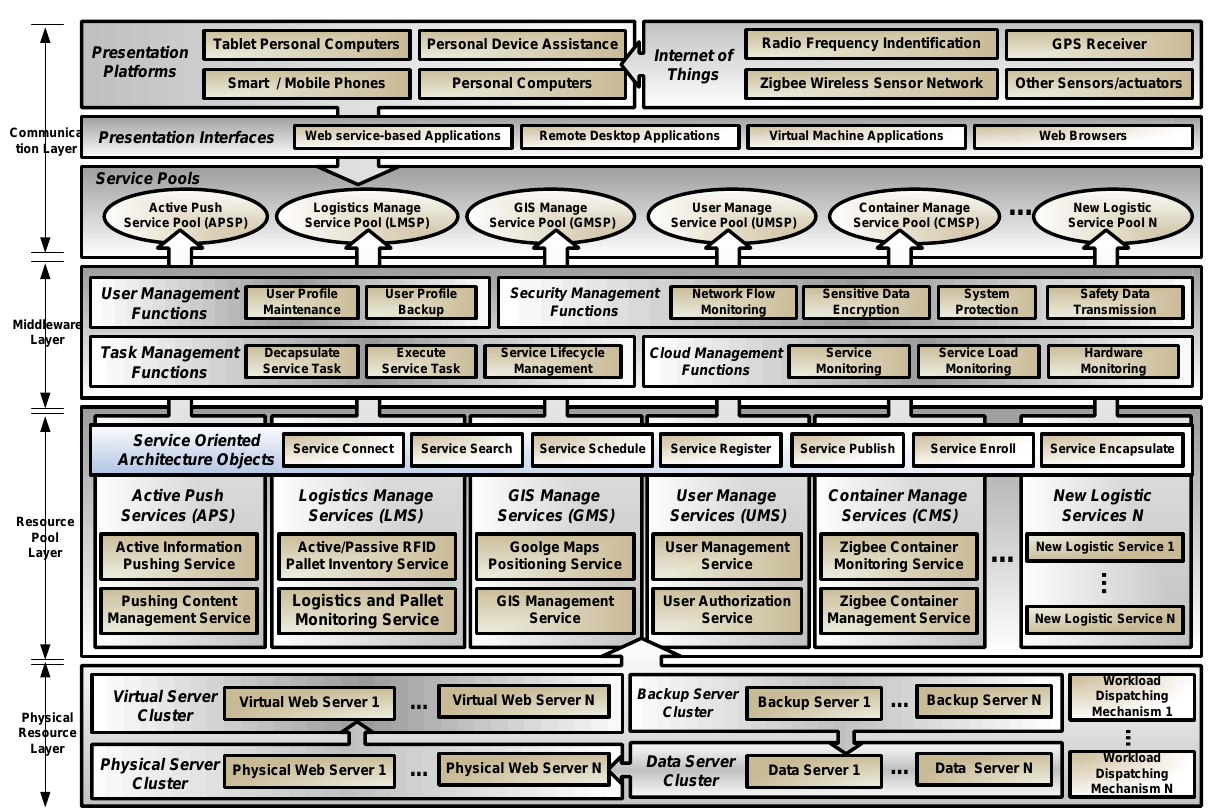
Figure 7. Framework of Logistic